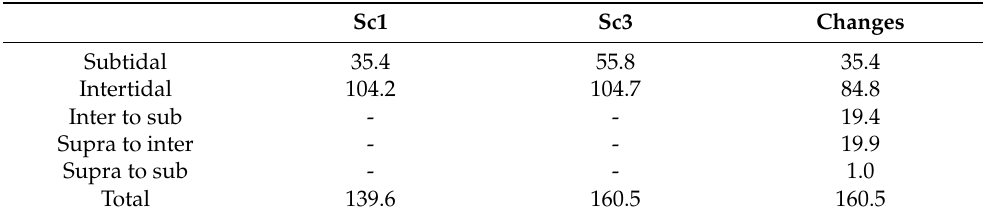
Table 1. Area (km 2 ) occupied by each lagoon environment and the respective changes induced by MSL